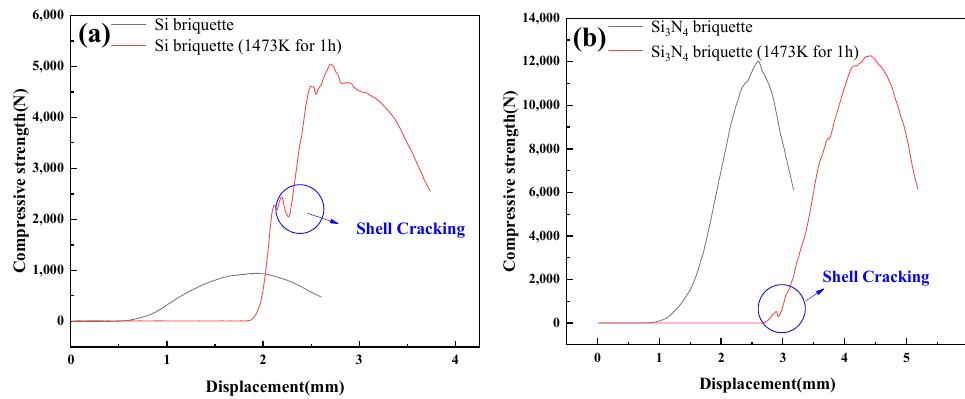
Figure 4. Cross-sectional photographs of ( a ) Si briquette; ( b ) Si briquette after being treated at 1473 K for 1 h; ( c ) Si 3 N 4 briquette; ( d ) Si 3 N 4 briquette after being treated at 1473 K for 1 h.